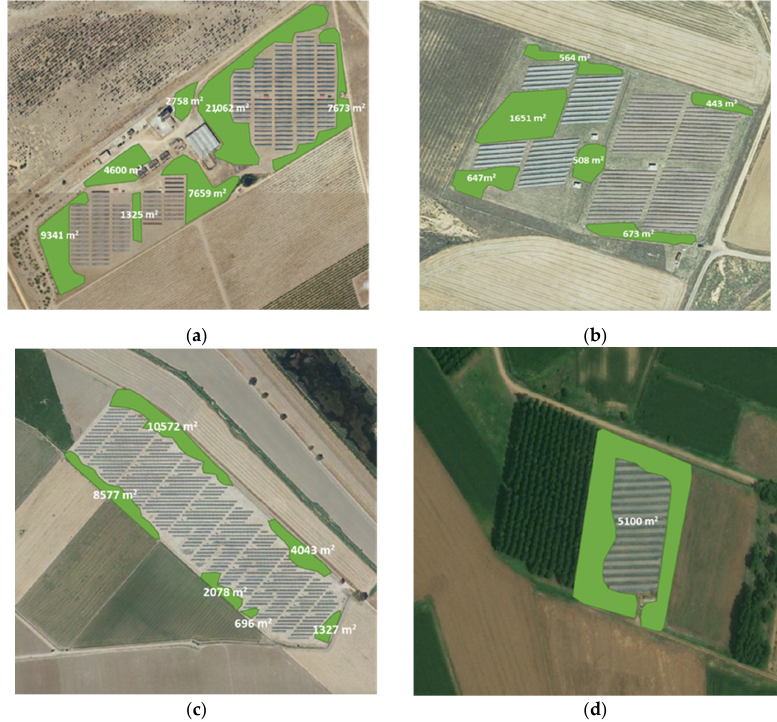
Figure 10. Areas detected and quantified by the INSPECTORMAP alert system for the dates that reveal greater vegetal vigor: ( a ) plant 1, ( b ) plant 3, ( c ) plant 4, and ( d ) plant 6.